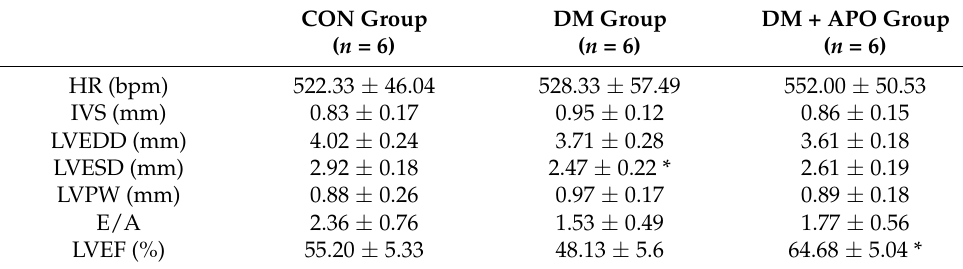
Figure 1. Apocynin (APO) improves cardiac function in diabetic mice. ( A ) C57BL/6 mice were induced with type 2 diabetes by high-fat diet combined with low-dose STZ. The DM+APO group was given APO (40 mg/kg) dissolved in corn oil by daily gavage. ( B , C ) Blood glucose and body weight in the 3 groups. ( D ) Representative two-dimensional and M-mode of echocardiographic images. ( E ) Analysis results of left ventricular ejection fraction (LVEF). ( F ) Results of hemodynamic studies (SBP, DBP, and MBP). ( G ) Ratio of heart weight (HW) to tibial length (TL) of mice in each group. Data are mean ± SD; n = 6 mice per group; * p < 0.05, *** p < 0.001. Table 1. Echocardiographic parameters of mice in the three